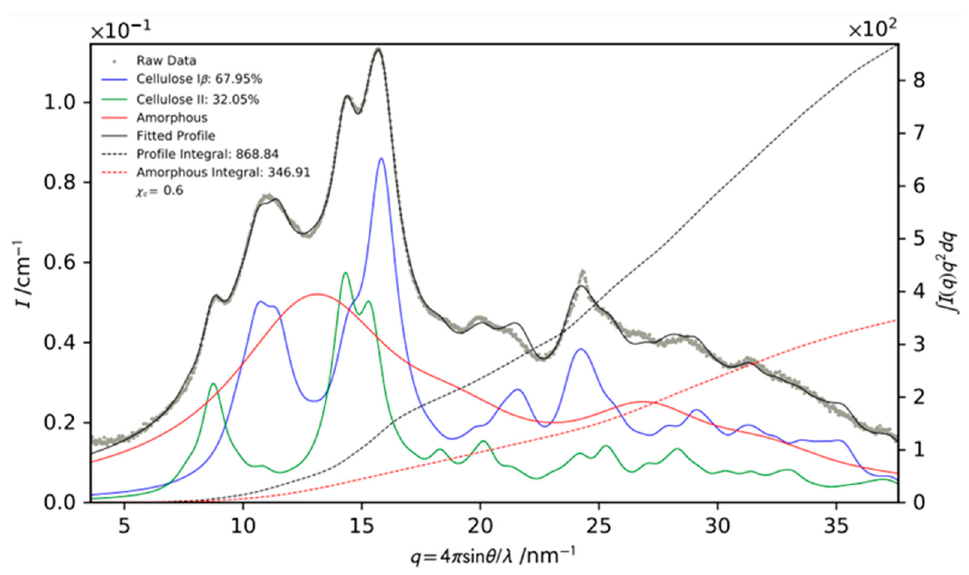
Figure A1. Rietveld refinement analysis of an XRD refractogram of depolymerized cellulose (DC) with an avDP of 32AGU.